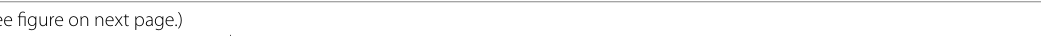
figure on next Fig. 5 Hsp90 regulated HPV16 + cervical cancer cell proliferation and migration via PD‑L1. In Caski and SiHa cells A Western blotting image and analysis of Hsp90, HER2, AKT, p‑AKT, PD‑L1 expression in control, sh‑NC, sh‑Hsp90#1, sh‑Hsp90#1 assay evaluating cell proliferation. C Transwell assay evaluating cell migration. D Western blotting assay was used to detect the expression of PD‑L1 in PD‑L1‑deficient Caski and SiHa cells. E Western blotting image and analysis of Hsp90, HER2, AKT, p‑AKT, PD‑L1 in PD‑L1‑deficient or PD‑L1‑deficient Hsp90 Caski and SiHa cells. F MTT assay evaluating cell proliferation. G Transwell assay evaluating cell migration. N + group. * p < 0.05, ** p < 0.01 or *** p <